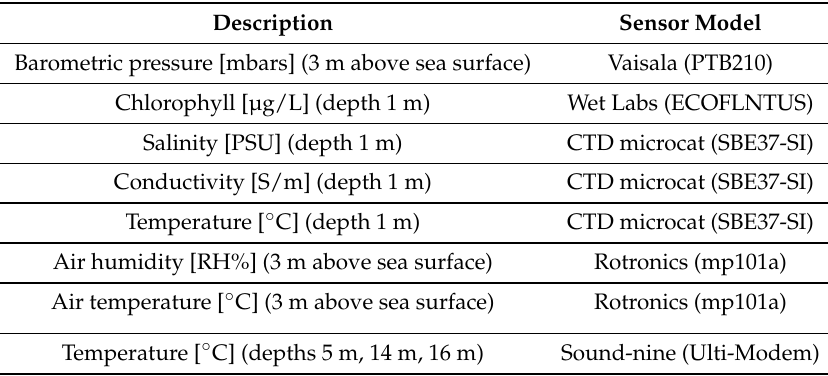
Table 1. Spesification of sensors used for data